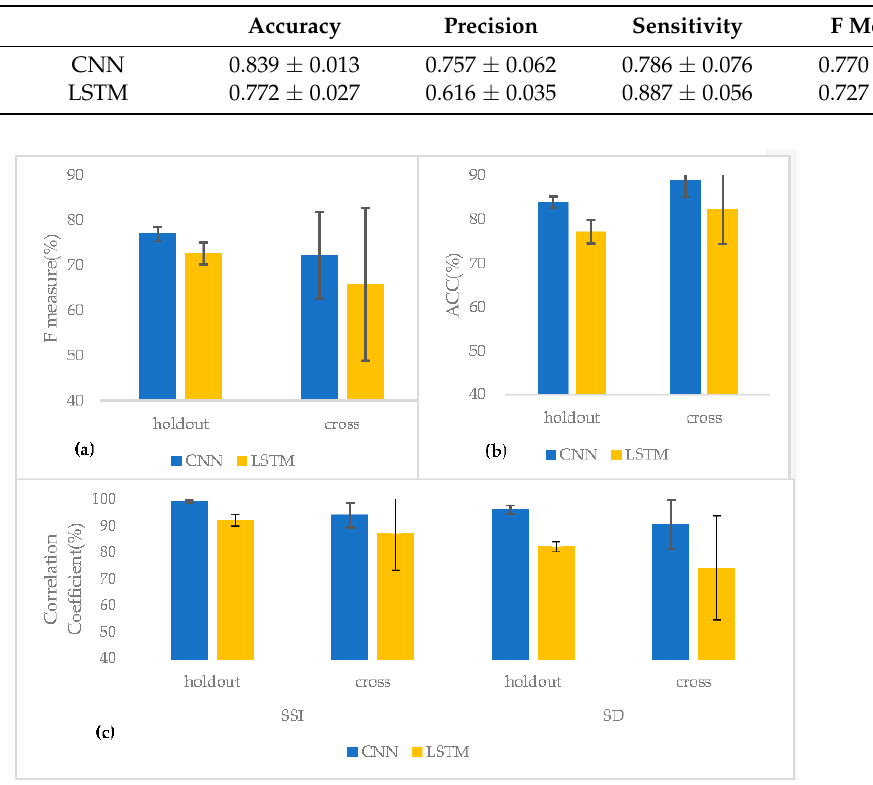
Table 2. Holdout evaluation results for the two models. Accuracy